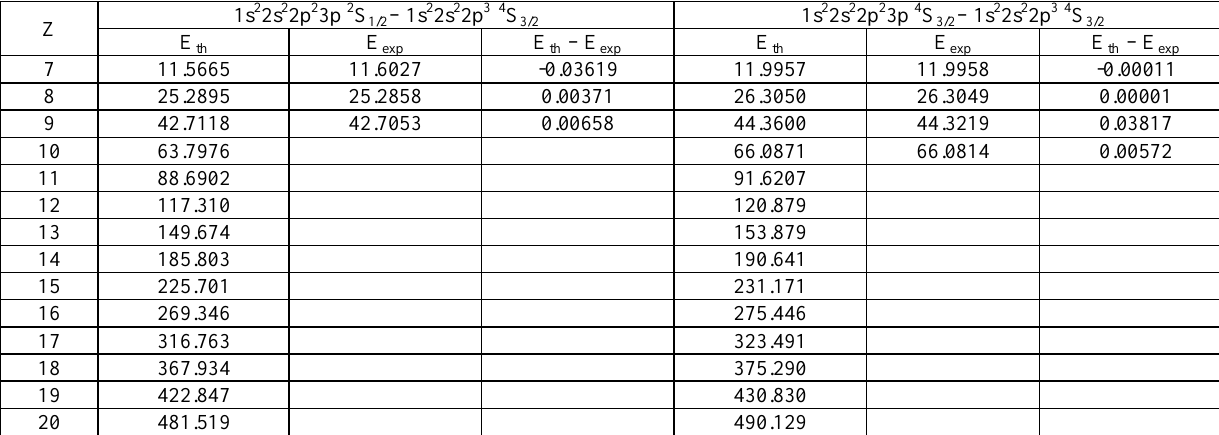
ions with Z = 7-9 only. As seen from the comparison, the relative deviation of the theory from measurements is in the order of 10 -4 - 10 -3 . Table 5. Experimental data [12]-[13] are available for Table 5. Comparison with experiments of the calculated energies (in eV) of 1s 2 2s 2 2p 2 ( 3 P)3p 4 P 5/2 states of nitrogen-like ions